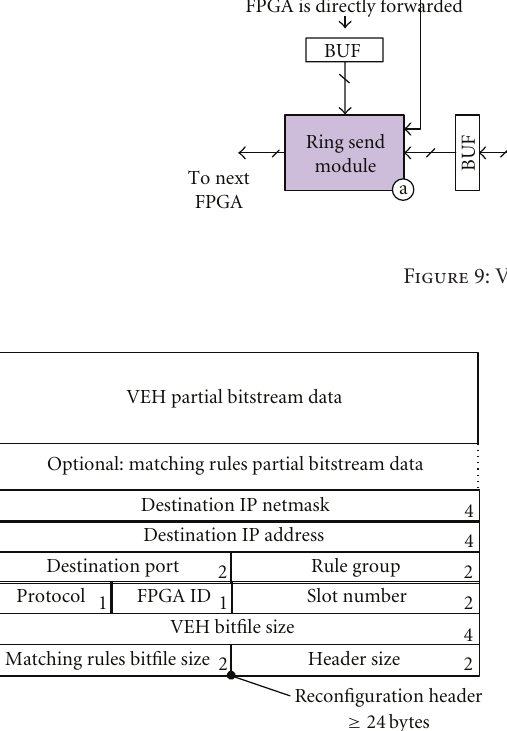
Figure 10: Custom PR header and bitstream